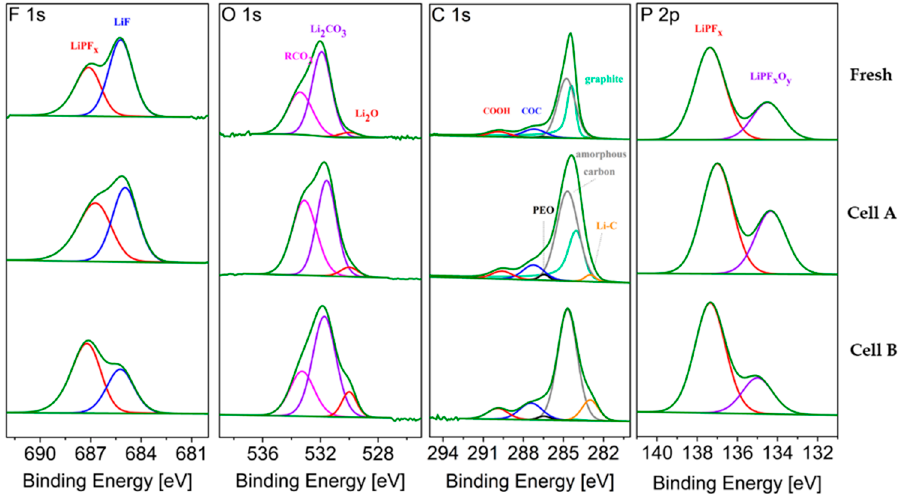
Figure 8. F 1s, O 1s, C 1s and P 2p core peaks XPS spectra of graphite electrode from fresh and aged cells (MC samples). Non-sputtered samples. Table 6. Average atomic percentages (% at.) determined from three measurement spots on fresh and aged graphite electrodes. Region Components